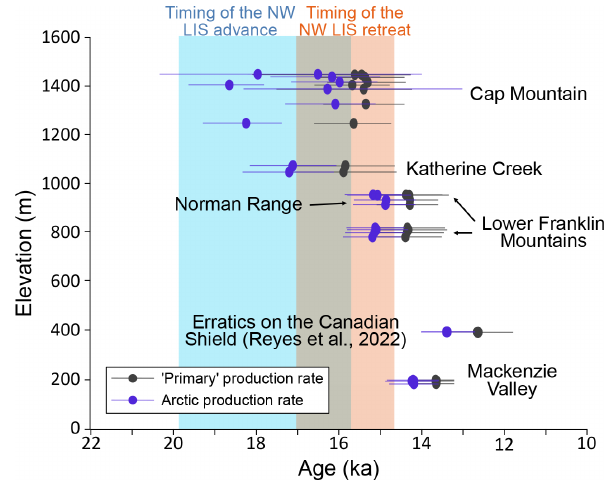
Figure 8. The influence of the exposure age calculation approach on the reconstructed age of deglaciation. Shaded orange and blue areas are based on the age constraints in Fig. 7. The primary produc- tion rate exposure ages were calculated using the primary calibra- tion dataset (Borchers et al., 2016), LSDn scaling, and a correction for glacioisostatic adjustment (as described in Sect. 2.1.3) and plot- ted using the modelled age distribution output of Bayesian model 2 and 5 (Figs. S3 and S4; Tables S3 and S4). The Arctic production rate exposure ages were calculated using the Arctic production rate (Young et al., 2013), Lal–Stone scaling, and a correction for GIA (as described in Sect. 2.1.3) and plotted using the modelled age distribution output of Bayesian model 8 and 11 (Figs. S5 and S6; Tables S5 and S6). The wide spread of modelled ages for the Cap Mountain site is a result of the smaller uncertainties associated with exposure ages calculated with the Arctic production